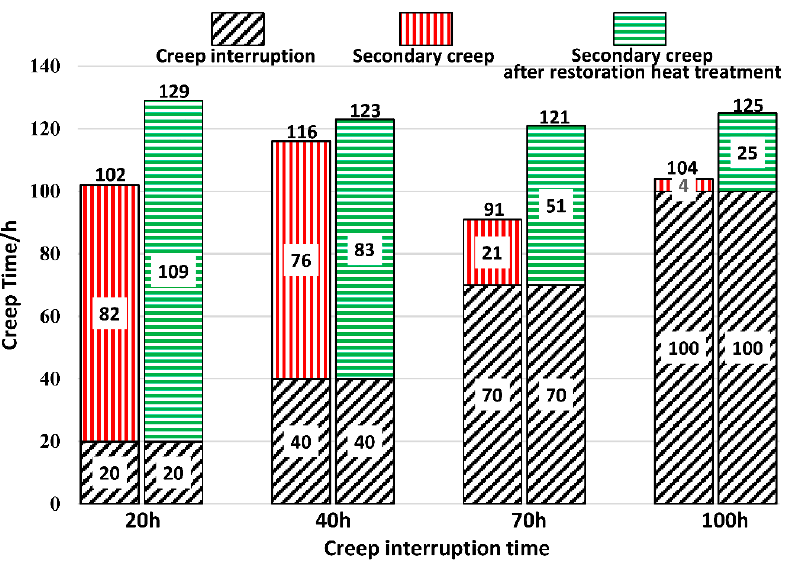
Figure 10. Creep life after two creep